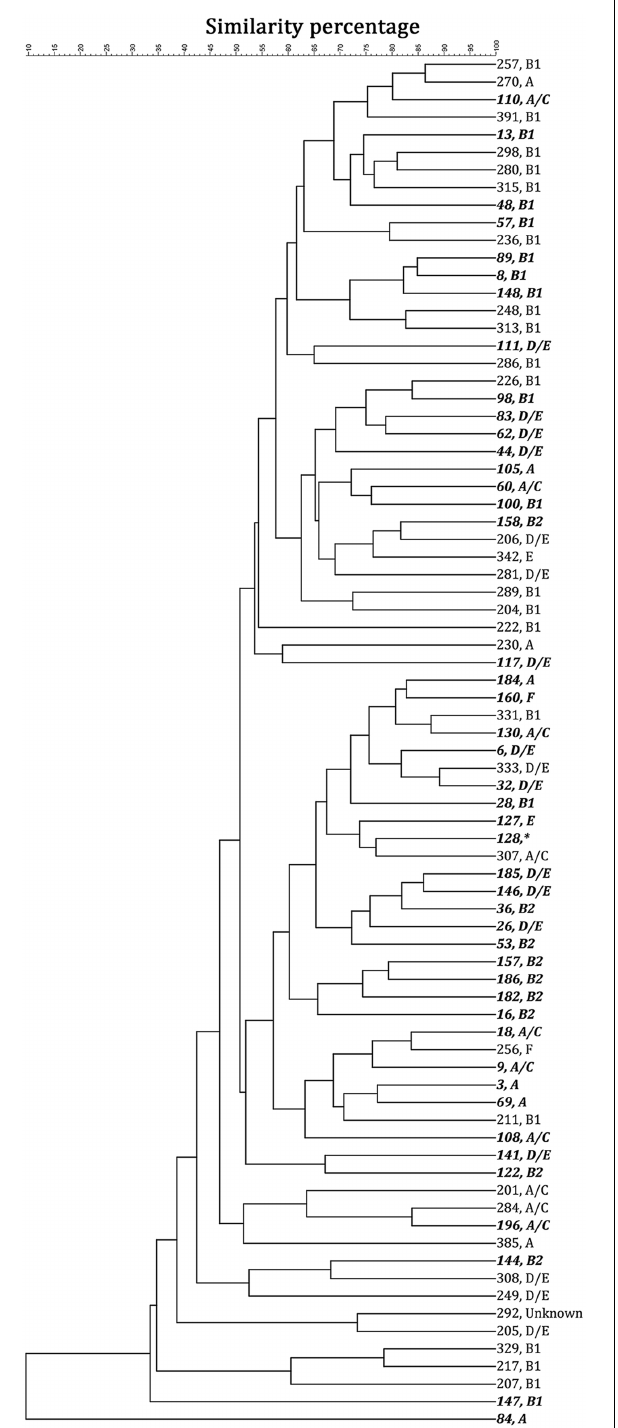
FIGURE 2 | The 78 strains selected for characterization showed less than 90% genomic similarity, based on a unweighted pair groups with mathematical averages (UPGMA) cluster analysis. Strains 1–200 (italic and bold) were collected from stream sediment; while 201–400 were collected from stream water. The strain number is followed by the phylotype analysis. ∗ Strain 128 could not be recovered for phylotype analysis.